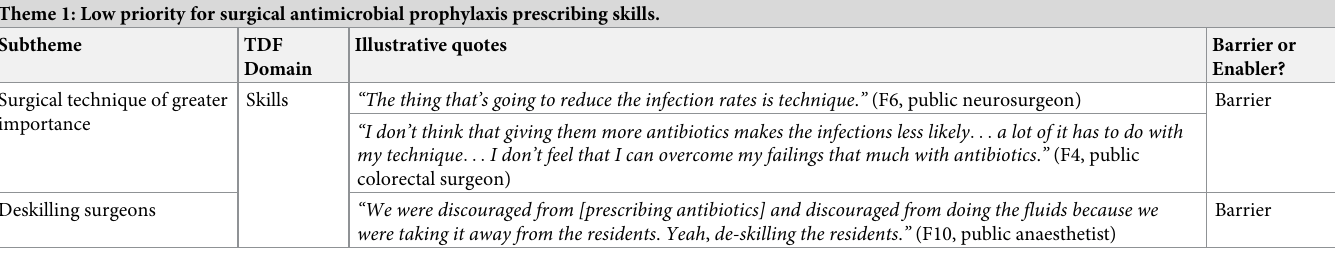
Table 2. Representative quotations from Theme 1 reflecting ‘Physical Capability’ of the COM-B model. Theme 1: Low priority for surgical antimicrobial prophylaxis prescribing